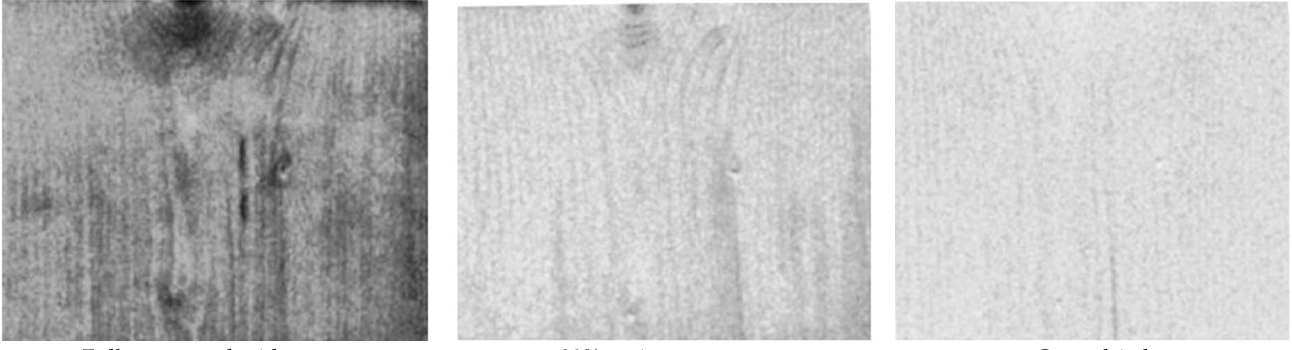
Figure 2. Using a 1550 nm wavelength scanner, scans were taken of a single section of cut pine board fully saturated with water, at approximately 30% moisture content, and oven-dried. When fully saturated, the board not only reflects less light, but reflectance is also more heterogenous across the surface.